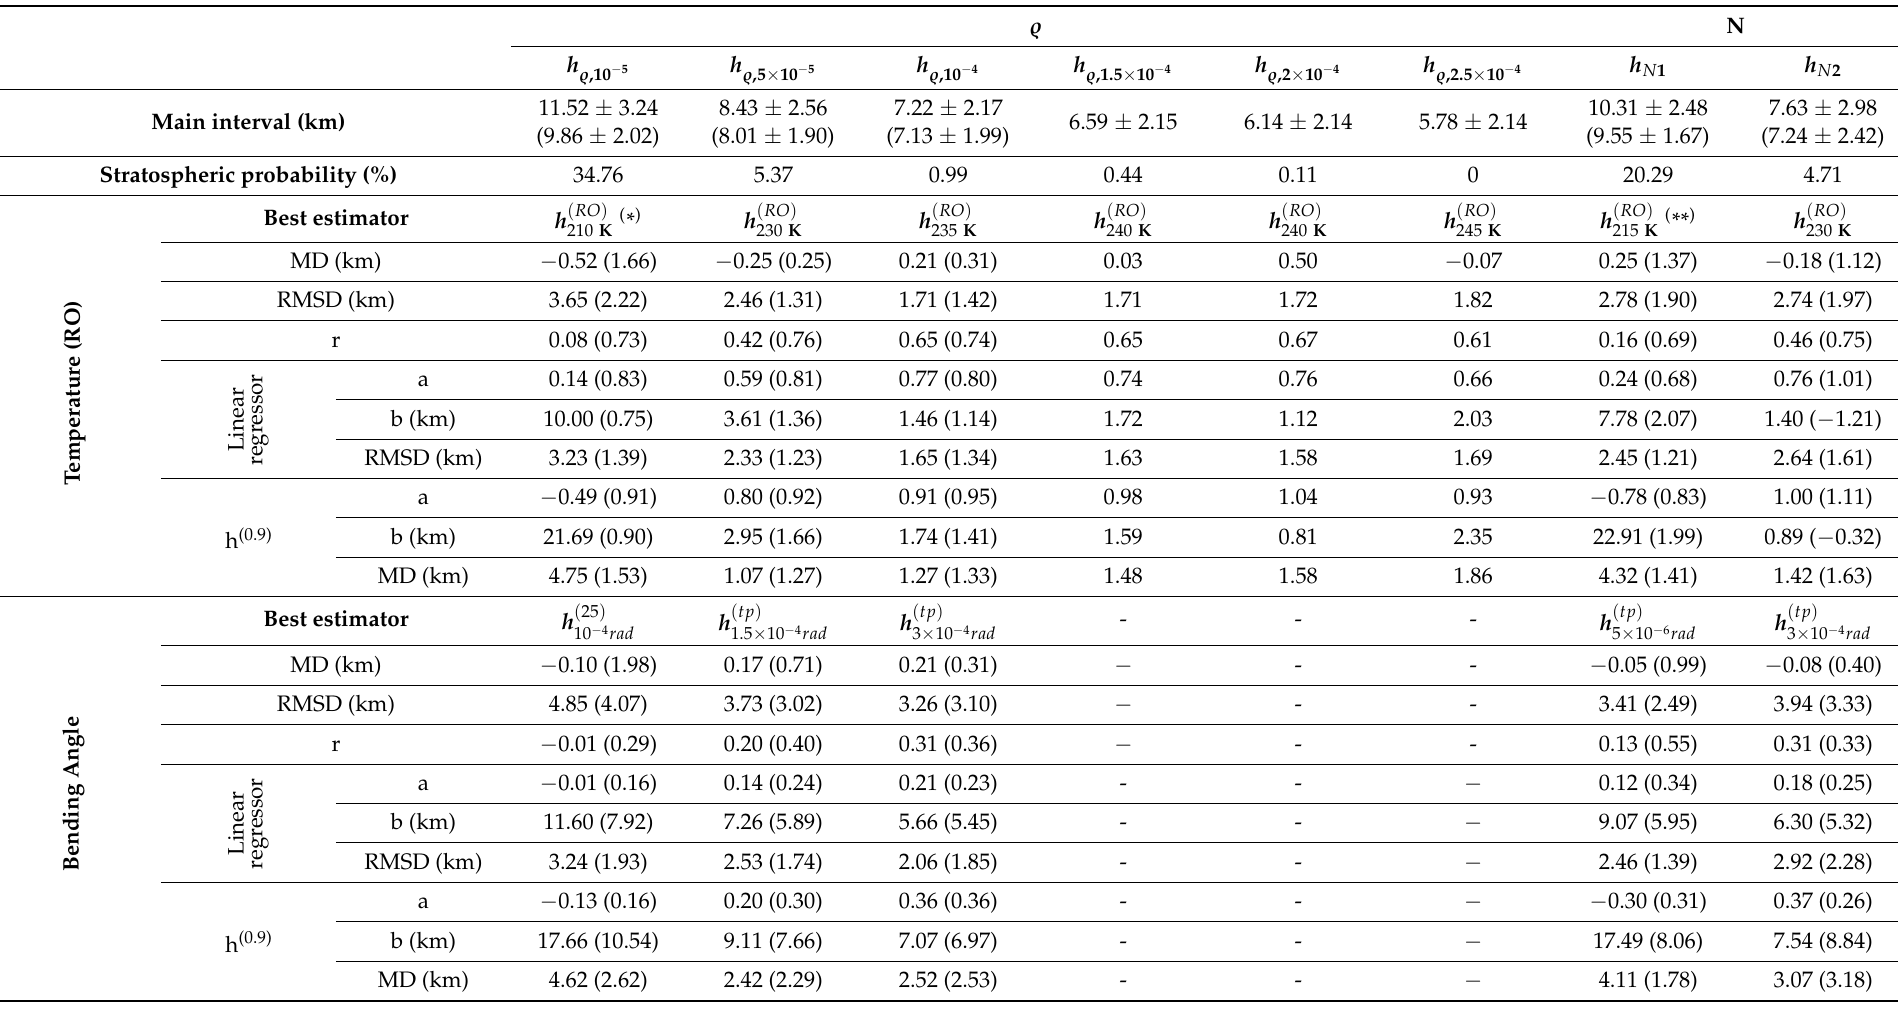
Table 2. Best estimators of the dry air starting altitudes. Data below give, in row order: (1) mean value and standard deviation for the starting altitude; (2) stratospheric probability for the starting altitude; (3) starting altitude best estimator; (4), (5) and (6) MD, RMSD and correlation coefficient r between the starting altitude and its best estimator; (7) and (8) a and b coefficients of the linear regressor h lin . regr . = a · h best est . + b ; (9) RMSD of the linear regressor; (10) and (11) a and b coefficients of the altitude h ( 0.9 ) = a · h best est . + b . ; (12) MD of the h ( 0.9 ) altitude. Data obtained by omitting stratospheric altitudes are reported in